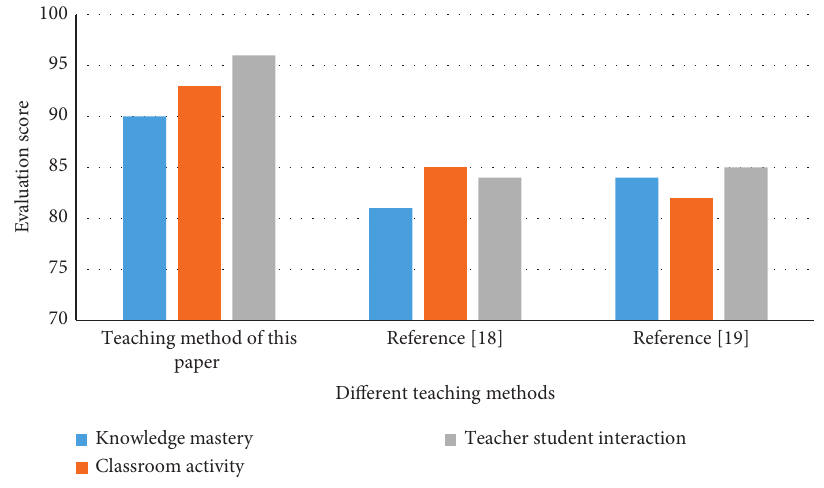
Figure 11: Comparison of different teaching methods.